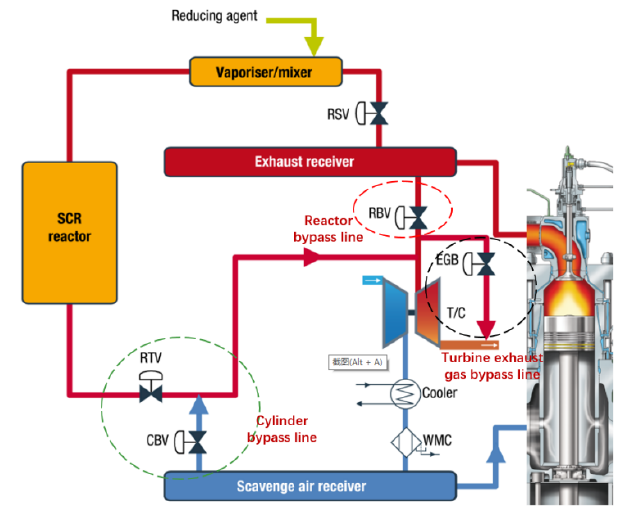
Figure 11. Flowchart of low-speed diesel engine main engine tuning method [18].